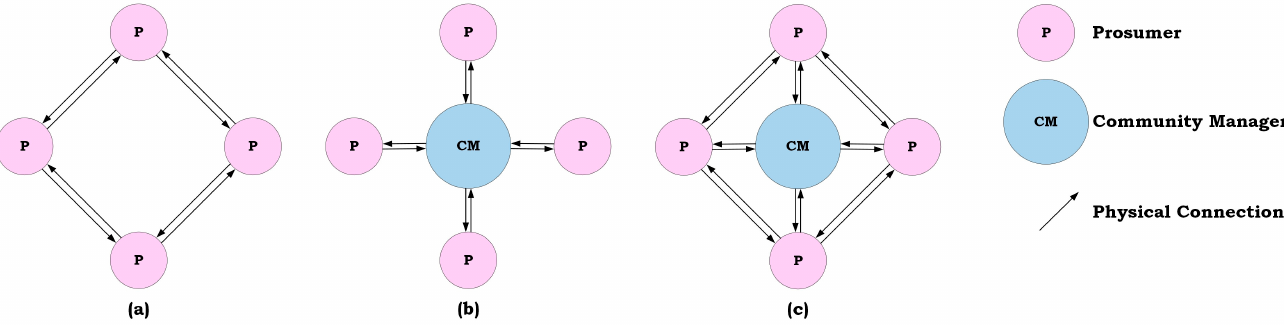
Table 4. Summary of energy trading mechanism for the P2P energy